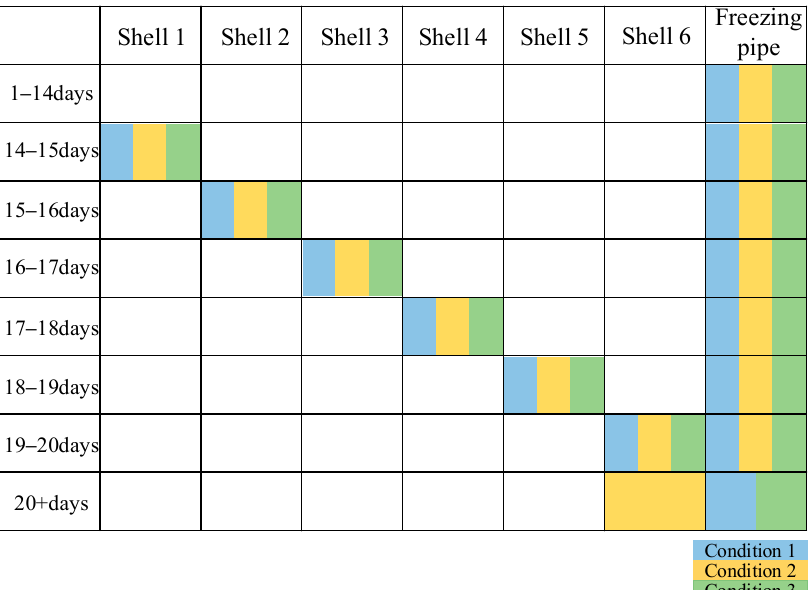
Figure 5. Relationship between model boundary and working conditions.